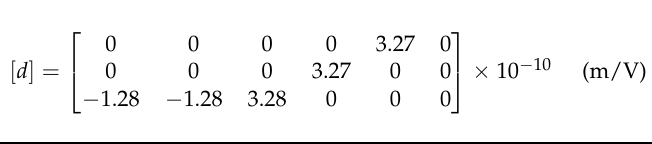
Table 4. Piezoelectric coefficients for the piezo layer in the three-layer beam case.